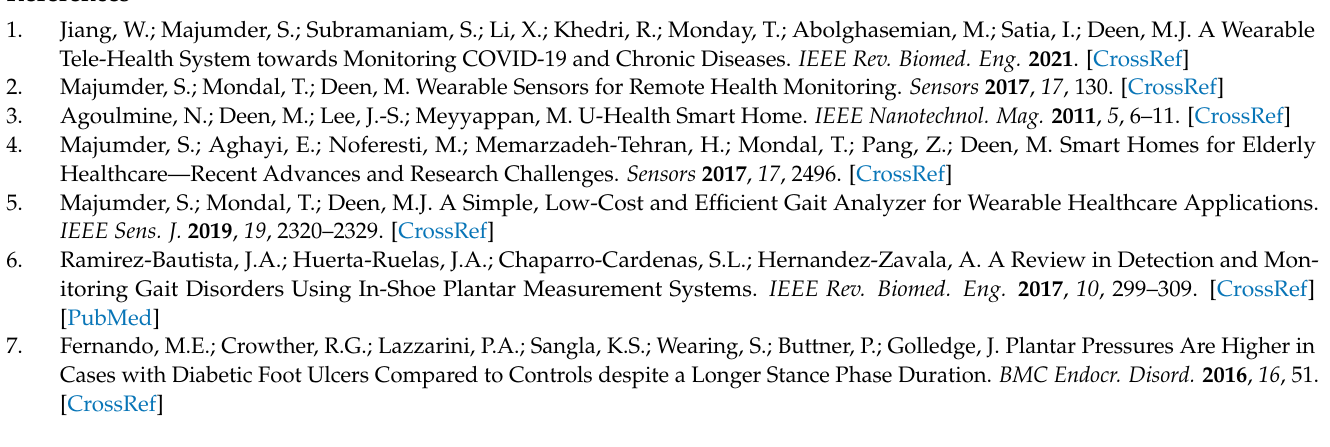
Figure Creation, S.S., S.M., A.I.F. and M.J.D.; Supervision: M.J.D. All authors have read and agreed